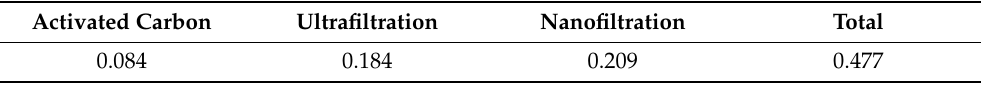
Table 5. Tertiary treatment costs (EUR/m 3 ).